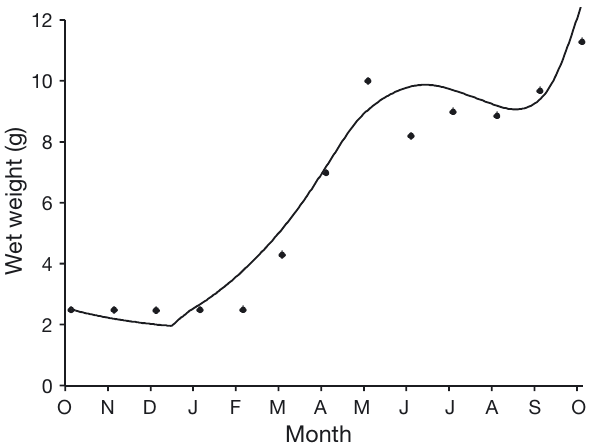
Fig. 4. Comparison between observed (dots) and simulated (line) growth of sea cucumber Apostichopus japonicus from a land-based culture system during October 1981−October